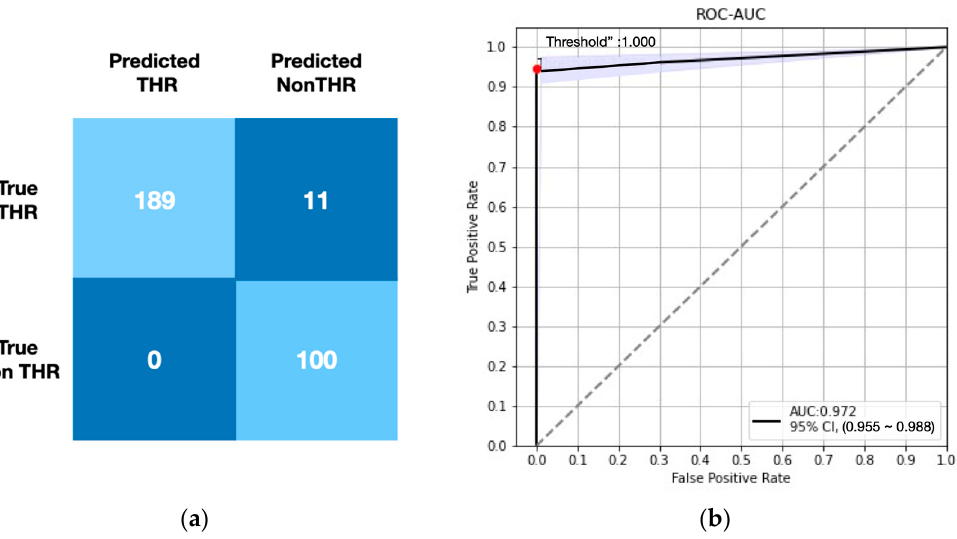
Figure 2. The confusion matrix and ROC Curve of SurgHipNet in real-world dataset. ( a ) The confusion matrix. ( b ) The ROC curve with area under curve. ROC: Receiver operating characteristic.